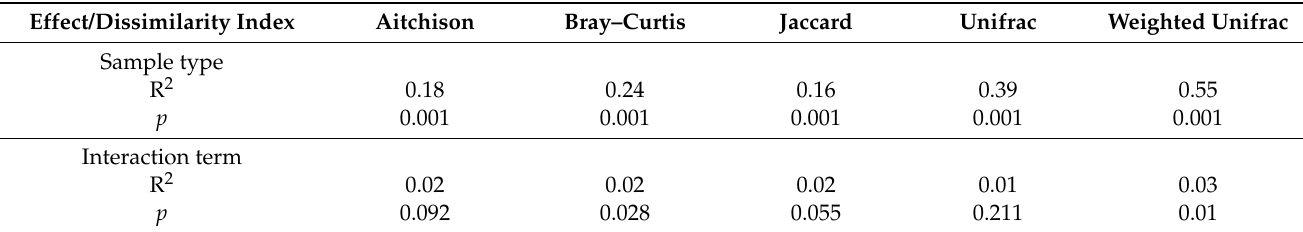
Table 3. Association of beta diversity dissimilarity indices with sample type (tracheal fluids and feces) and the interaction of sample type and Mycoplasma hyopneumoniae status.